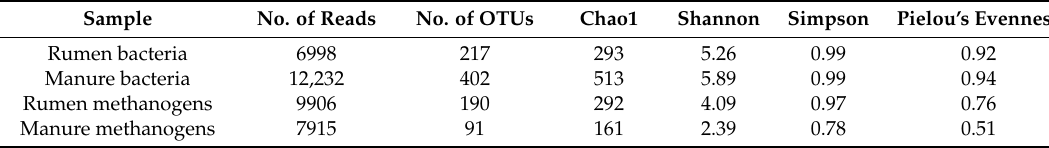
Figure 3. NMDS plots showing the Bray-Curtis dissimilarity of ( a ) the bacterial communities of rumen and manure samples based on 16S rRNA sequences and ( b ) the methanogenic communities of rumen and manure samples based on mcrA sequences. Table 1. Summary of the estimated richness and evenness of the bacterial and methanogenic communities of both compartments. Diversity indices were calculated with the QIIME pipeline, except the Shannon index, which was calculated according to Lucas et al. [37].